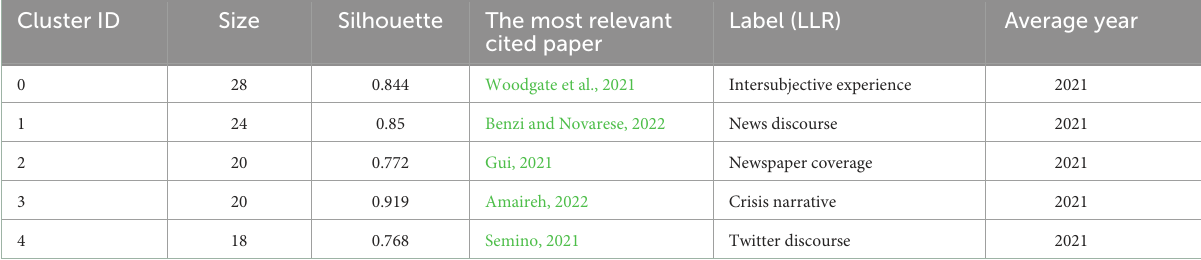
TABLE 4 Co-citation as per the cited paper.